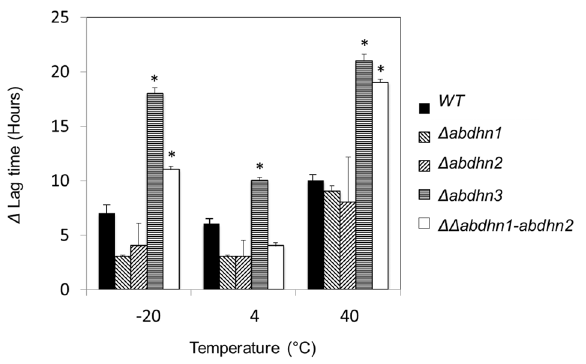
Figure 9. Susceptibility of AbDhn-deficient mutants to tem- perature stress. Calibrated water suspensions of conidia from the wild-type (WT) strain Abra43 and AbDhn-deficient mutants were left for 10 h at various temperatures ( 2 20 u C, + 4 u C, + 20 u C, + 40 u C). Conidia were then used to inoculate microplate wells and nephelometric growth curves were established over a 33 h period. D Lag time was calculated as the difference between the lag time at the tested temperature and the lag time at 20 u C and was used as a parameter to estimate the effect of the treatment on spore viability. Error bars indicate standard deviations and asterisks indicate values that are significantly ( P , 0.01) higher than that of the wild-type. Each genotype was analysed in triplicate and the experiments were repeated twice times per growth condition.